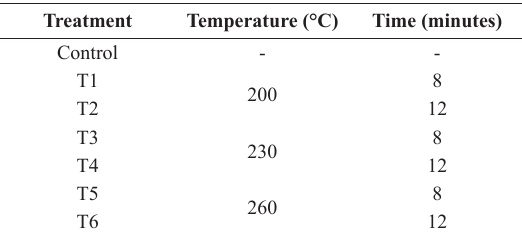
Table 1. Description of thermal treatment.